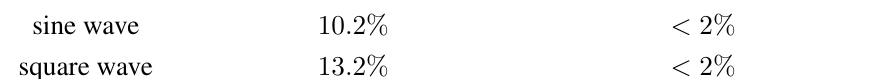
Table 9. Error characteristics’ coefficients.